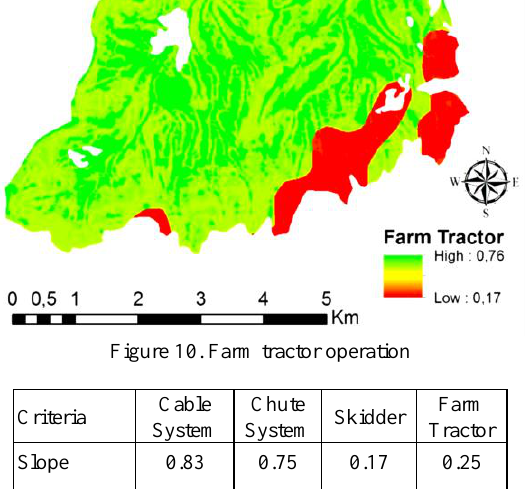
Figure 11. Optimum forest transportation